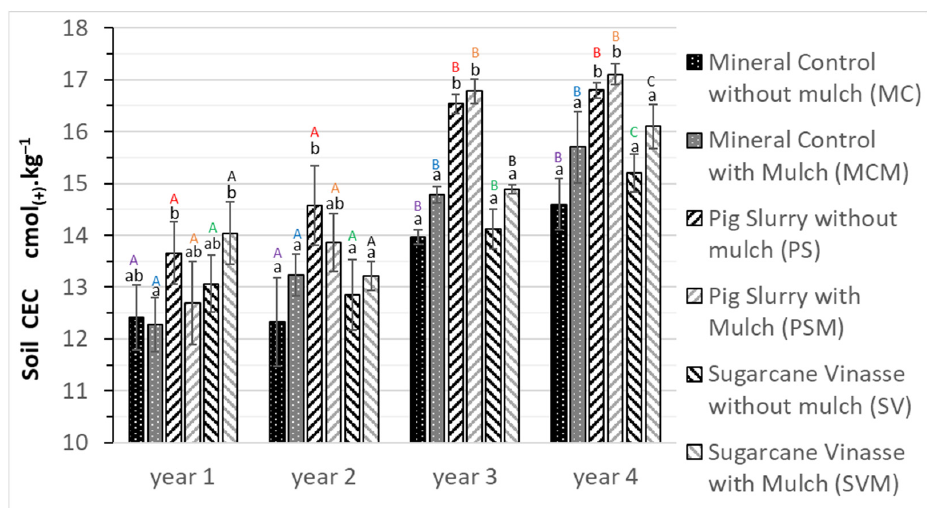
Figure 4. Cation exchange capacity (CEC) under each treatment in the four years. Error bars correspond to the standard deviation between replicates for each treatment. Identical letters indicate no significant differences between two modalities in a given year. Small letters compare treatments in a given year and capital letters compare treatments between years.